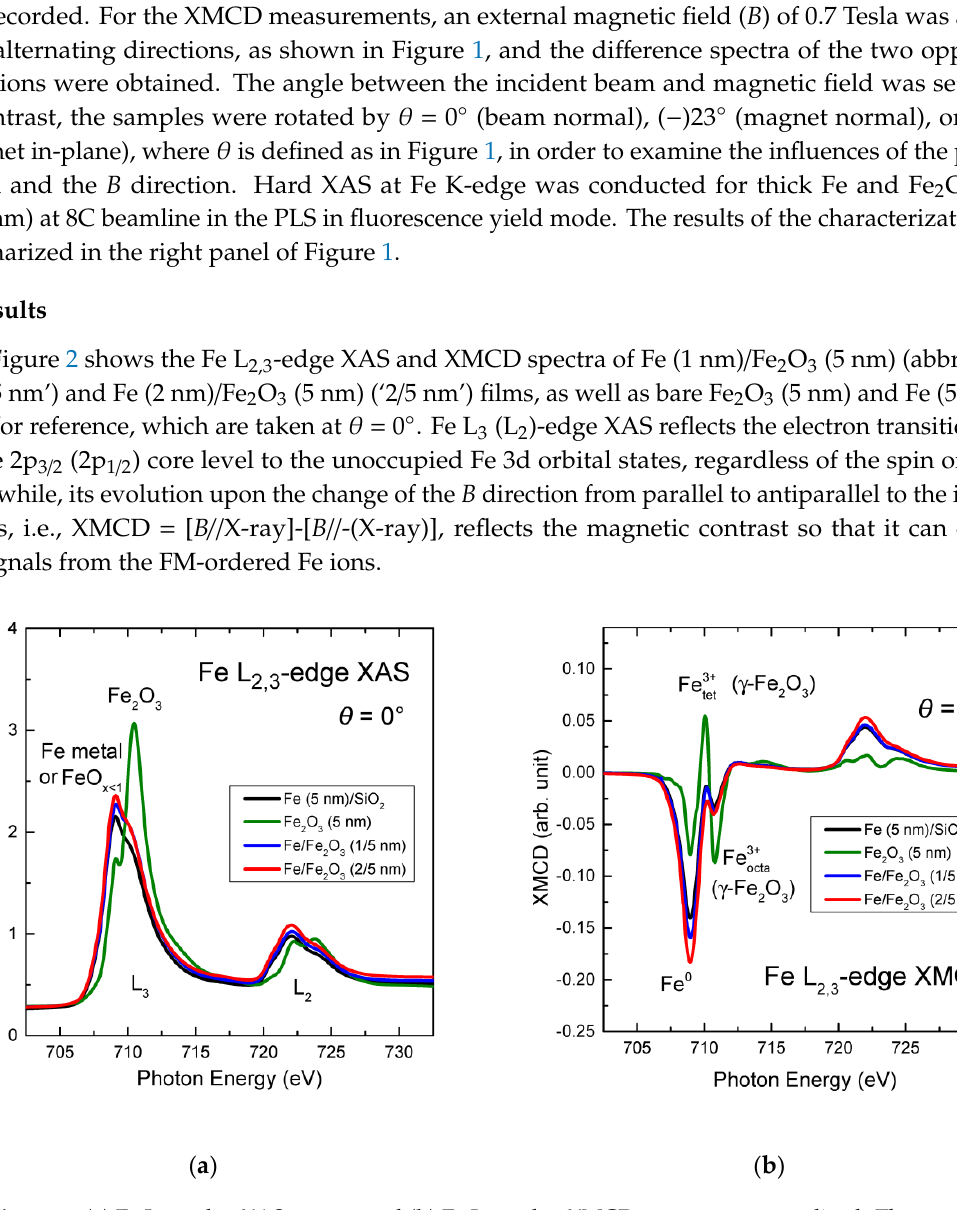
Figure 2. ( a ) Fe L 2,3 -edge XAS spectra and ( b ) Fe L 2,3 -edge XMCD spectra un-normalized. The spectra of Fe (1 or 2 nm) / Fe 2 O 3 , and Fe (5 nm) / SiO 2 samples exhibit the signature of Fe metal (or FeO x < 1 )